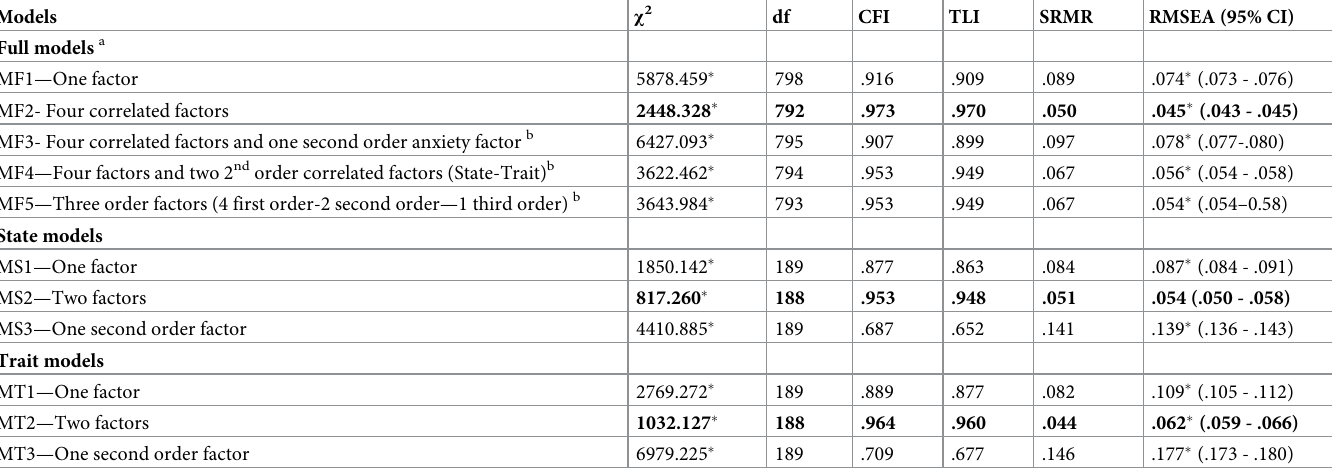
Table 2. Goodness of fit statistics for all concurrent models (n =